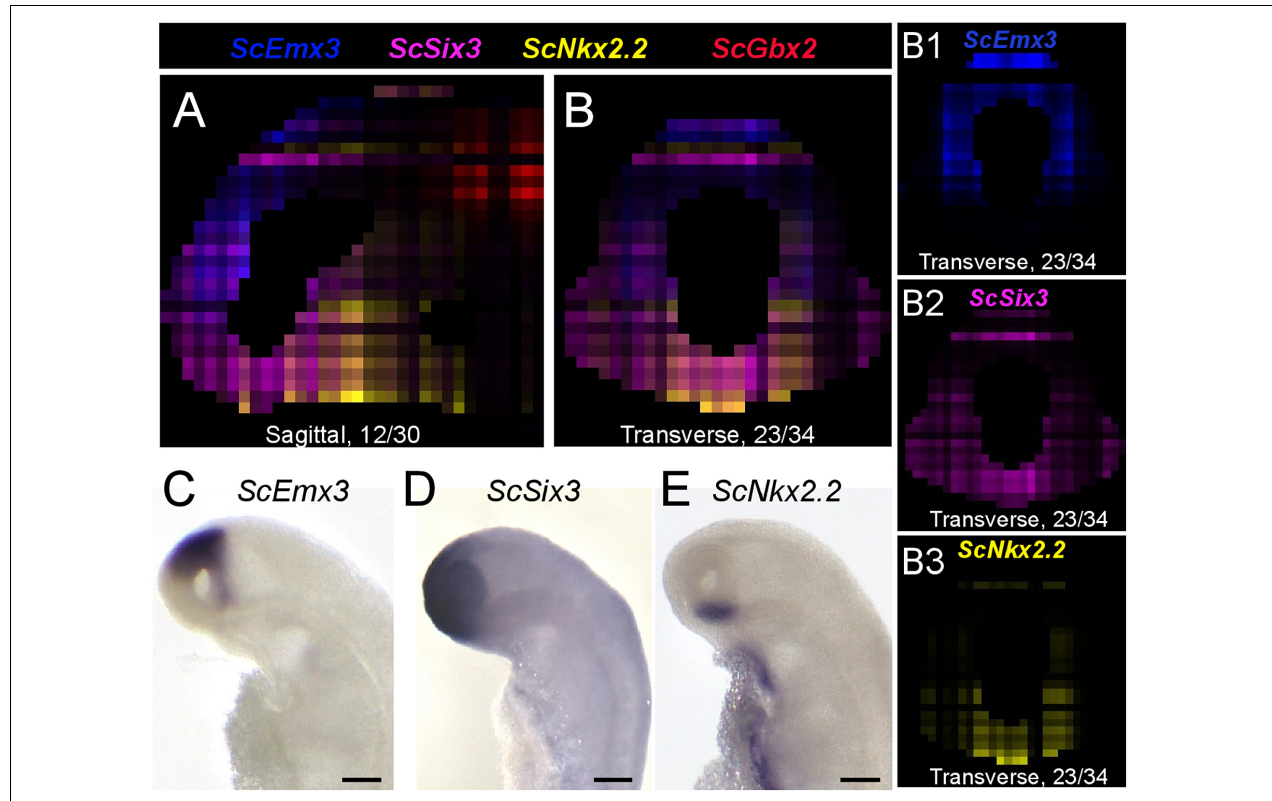
FIGURE 4 | Digital profiles reproduce regional patterns along DV axis. (A,B) Digital sagittal (A) and transverse (B) sections showing merged profiles of ScEmx3 (blue), ScSix3 (magenta), ScNkx2.2 (yellow), and ScGbx2 (red). Sections are numbered from left to right in panel (A) and from posterior to anterior in panel (B) . (B1–3) Digital sections showing the individual profiles merged in panel (B) for ScEmx3 (B1) , ScSix3 (B2) , and ScNkx2.2 (B3) . (C–E) Left lateral views of stage 17 catshark embryonic heads after ISH with probes for ScEmx3 (C) , ScSix3 (D) , and ScNkx2.2 (E) . Scale bars = 200 µ